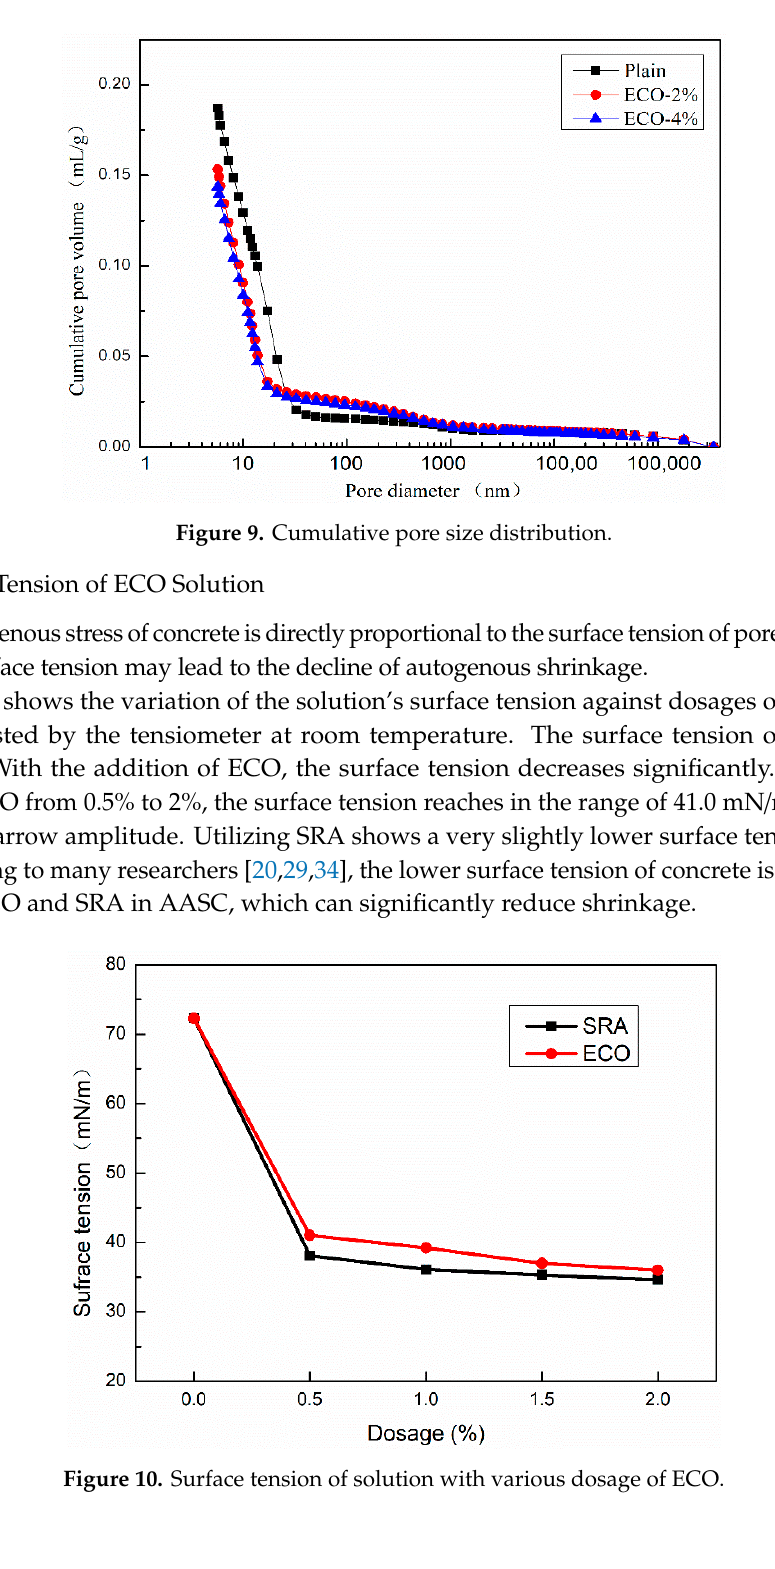
Figure 10. Surface tension of solution with various dosage of ECO.